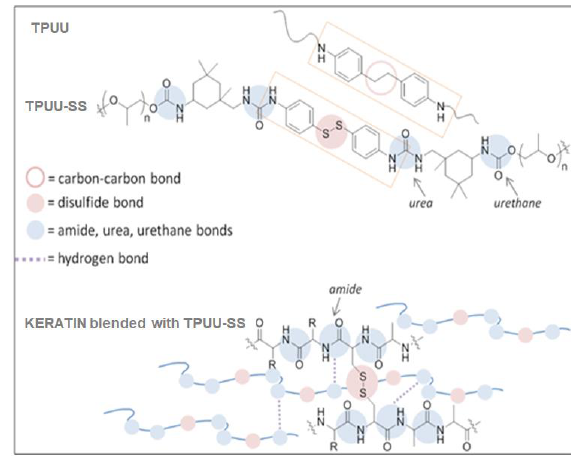
Figure 1. Chemical structure of TPUU, TPUU-SS and keratin.